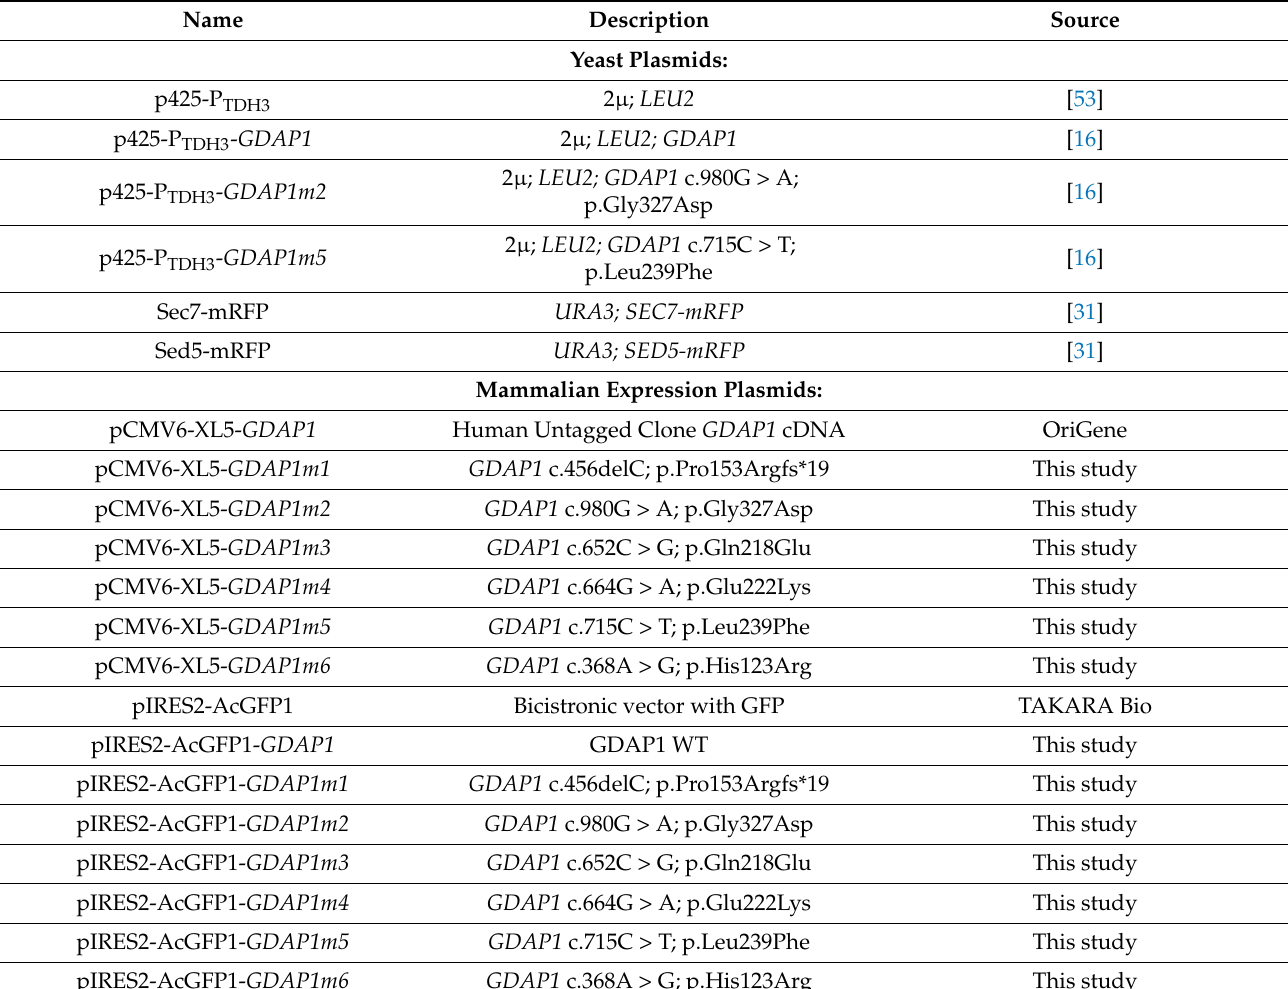
Table 1. Plasmids used in this